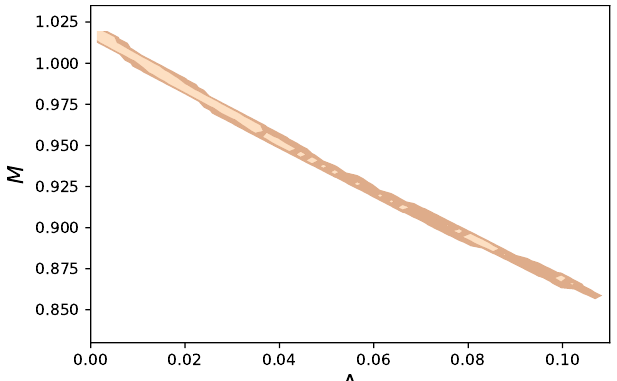
Figure 5. 1 σ and 2 σ parameter region consistent with S2 star observations, after a Monte-Carlo- Markov Chains